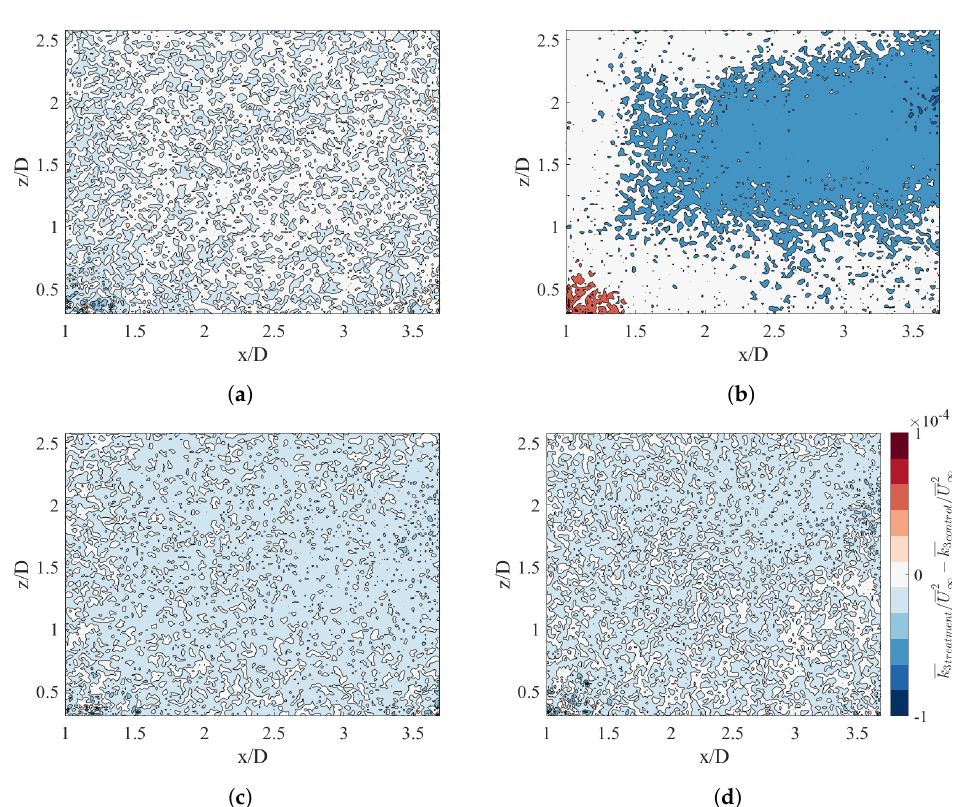
Figure 16. Differences between treatment and control of the TKE normalized by the freestream value: ( a ) centerline plane between rows one and two; ( b ) centerline plane between rows two and three; ( c ) rotor tip plane between rows one and two; and ( d ) rotor tip plane between rows two and three.